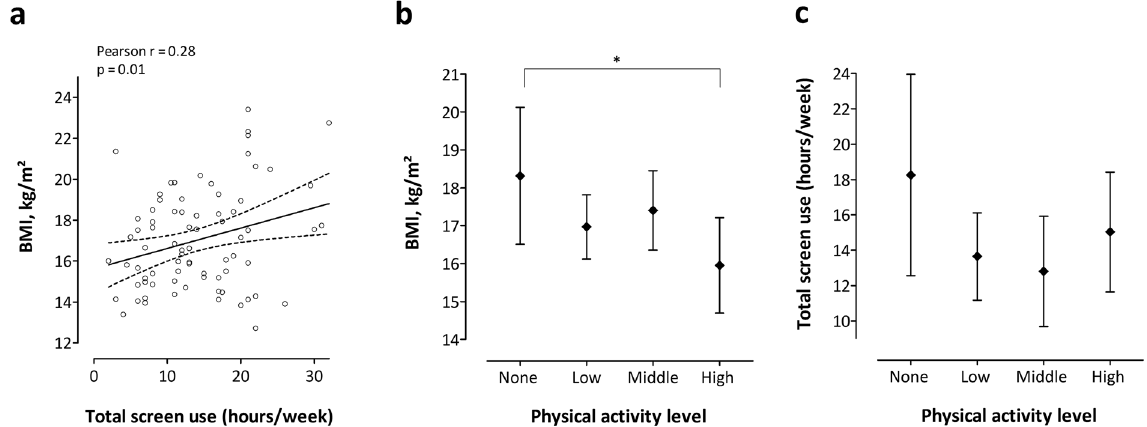
Figure 1. Correlation between total screen use, physical activity and body mass index (BMI). ( a ) Correlation between total screen use and BMI (line represents the linear fit of the correlation with the 95% confidence intervals), ( b ) Mean (95%CI) BMI in function of the physical activity level category, adjusted for age and gender of the child, ( c ) Mean (95%CI) total screen time in function of the physical activity level. * p <